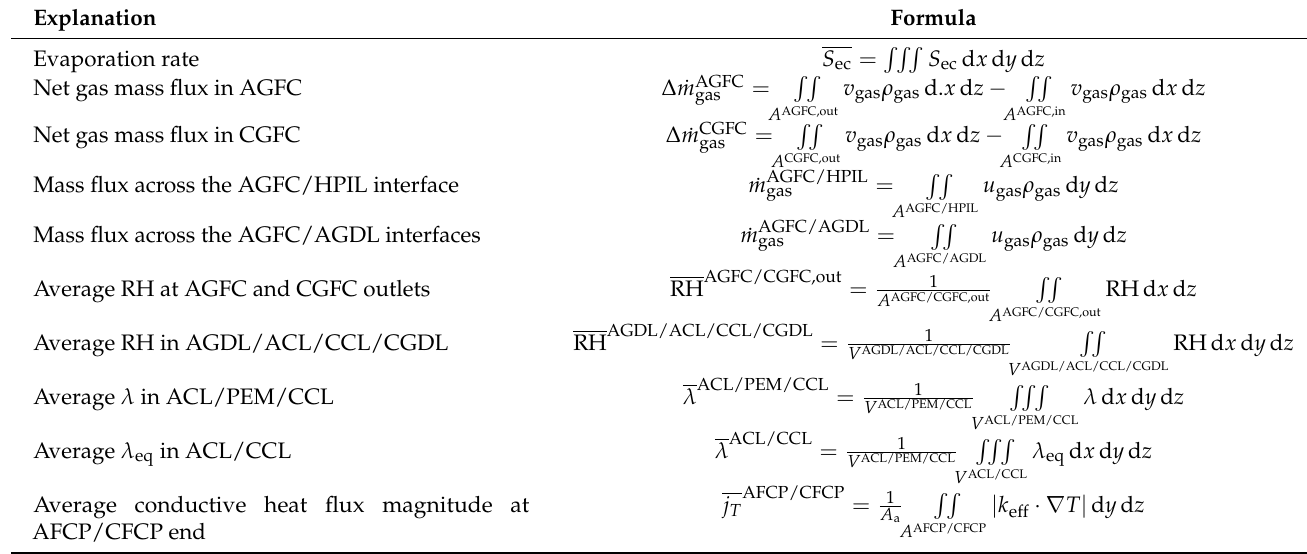
Table A5. Definition of output